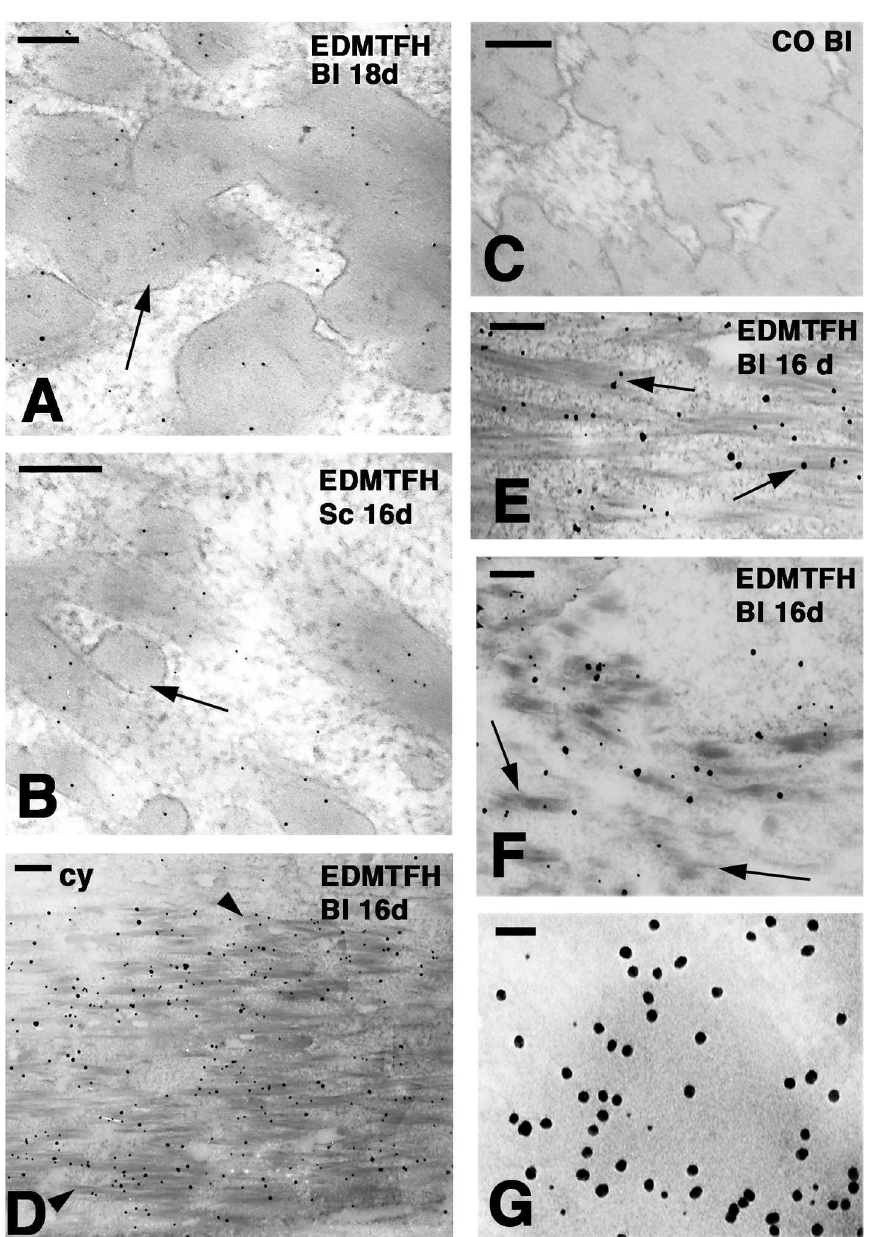
Fig 4. Ultrastructural localization of EDMTFH by immunogold labeling. Downfeathers and scales of chicken embroys at days 16 (16d) and 18 (18d) of development were labeledfor EDMTFH either without ( A-C, G ) and with ( D-F ) silver enhancement. ( A ) Diffuse labelingover corneous bundles(arrow) of barbule cells (bl). ( B ) Diffuse labelingin the corneous bundles(arrow) of a subperiderm cell in a scale. ( C ) Immuno- negativecontrol section of a barbule.( D ) Labelingcytoplasmiccorneous bundles (arrowheads) but not the cytoplasm (cy) in a barbulecell (bl). ( E ) Close-upto show the associationof the labelingwith corneous bundles(arrows). ( F ) Early differentiating barbule cell with short corneous bundles (arrows). ( G ) Double- labelingfor EDMTFH (5 nm gold particles) and feather beta-keratin (20 nm gold particles) in a barbulecell. Note that the large particles appearto be more abundantthan the small particles. A lower magnification image of the double-labeling is shown in S3 Fig. Bars: 100 nm ( A , B ); 200 nm ( C-F ); 50 nm ( G ).